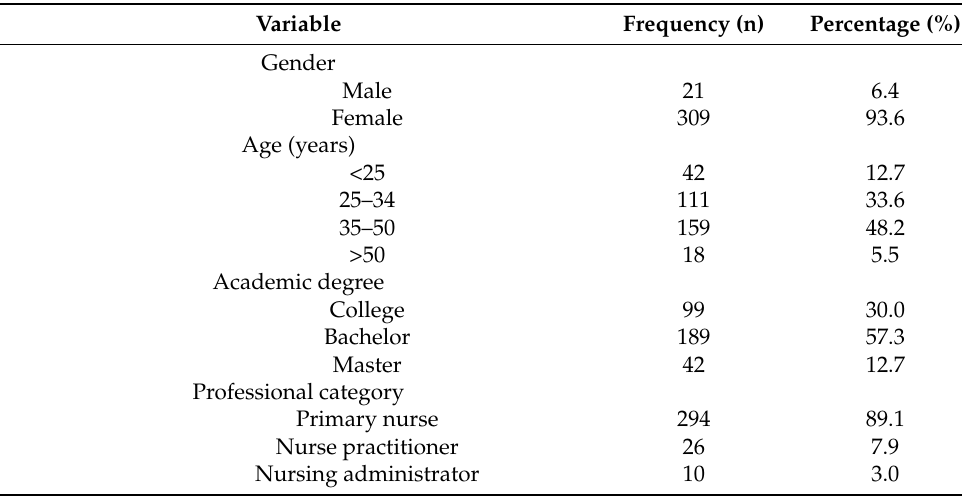
Table 1. Characteristics of participants’ analysis ( N =